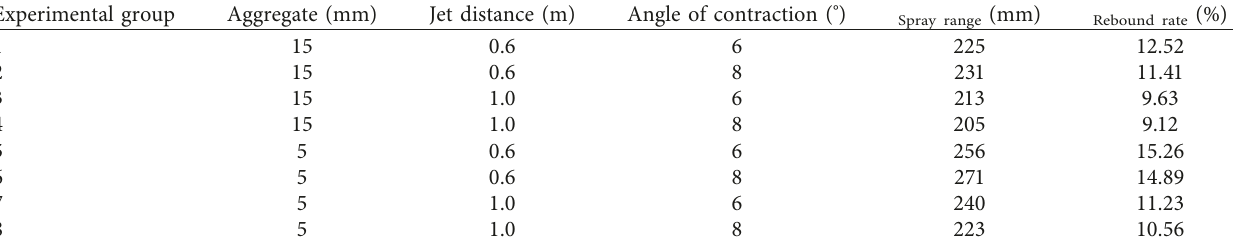
Table 3: Field test record